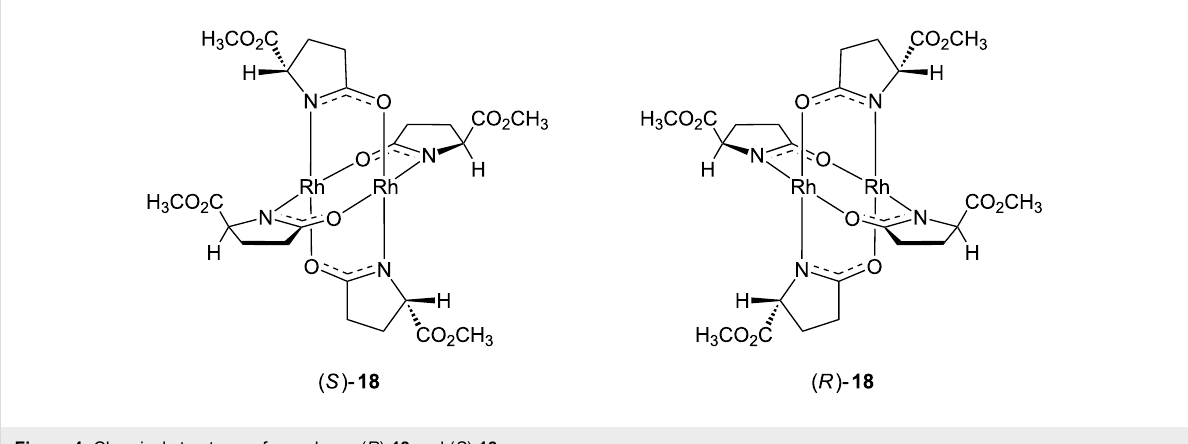
Figure 4: Chemical structures of complexes ( R )- 18 and ( S )- 18 .